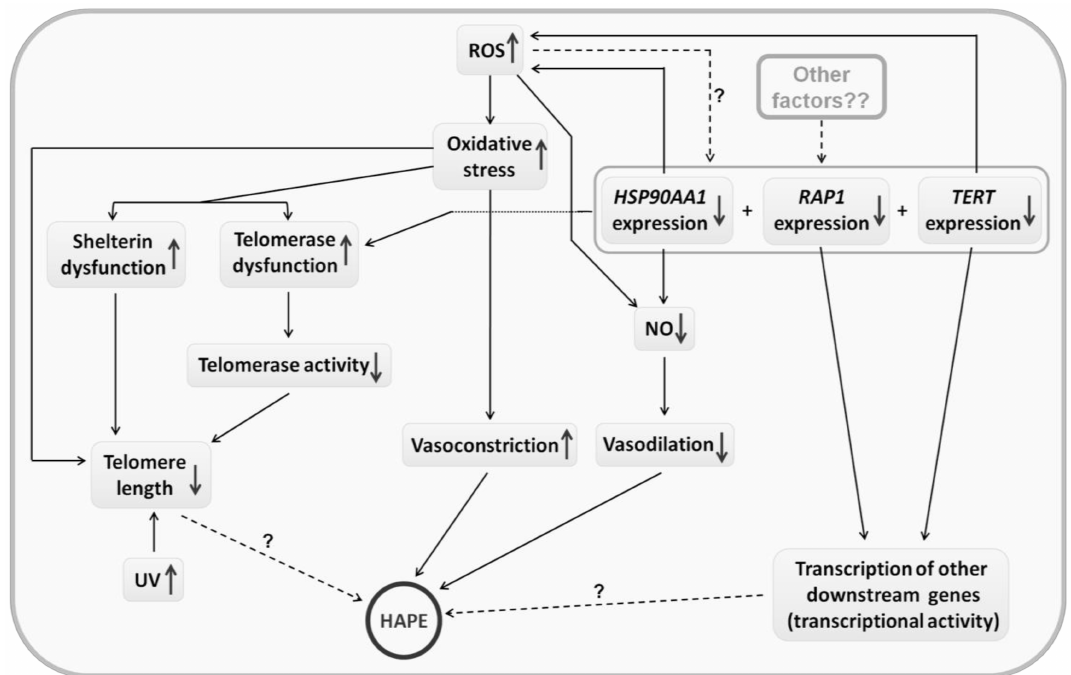
Figure 5. The proposed pathophysiology of HAPE. Hypobaric hypoxia is a stimulant to stress, which may in turn stimulate a normal physiological system to sustain a normal status which may not be possible in a few subjects. The same is depicted in the given graphical sketch. The expression of various proteins and genes, which are essential to regulate ROS production is dysregulated on exposure to HA. The telomere system is one of the major systems, whose genes/proteins are significantly disturbed. Down-regulation of HSP90AA1 , TERT and the telomerase is observed and contributes to telomere attrition and may also enhance ROS production in a reversible process. Overall, in this milieu, the exaggerated ROS and the down-regulated candidate markers lead to the NOS3-mediated decrease in NO production and enhanced vasoconstriction leading to the disturbance of vascular homeostasis causing pulmonary hypertension, a hallmark of